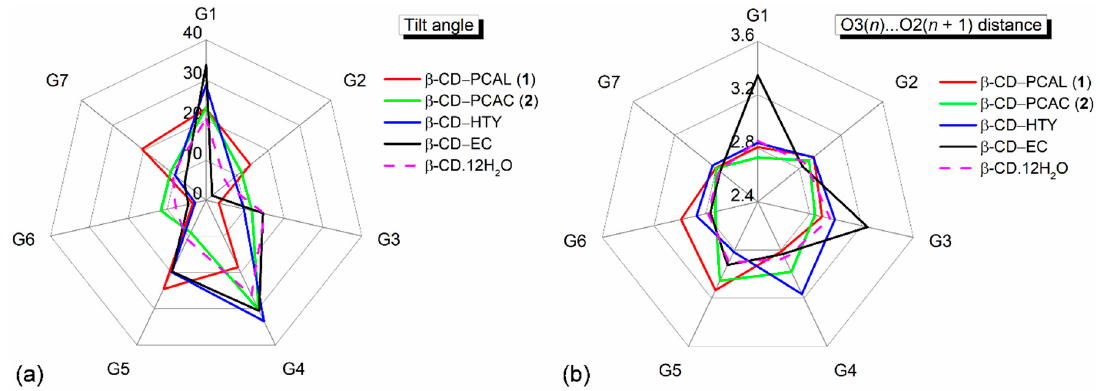
Figure 2. Radar plots comparing ( a ) tilt angles and ( b ) O3( n )···O2( n + 1) distances of the β -CD glucose units (G1–G7) influenced by the inclusion of PCAL ( 1 ), PCAC ( 2 ) and HTY [35]. For comparison, data of the inclusion complexes of β -CD–(–)-epicatechin(EC) [43] and the uncomplexed β -CD·12H 2 O [42] are incorporated; see also Table S2. Angles and distances are in ° and Å.